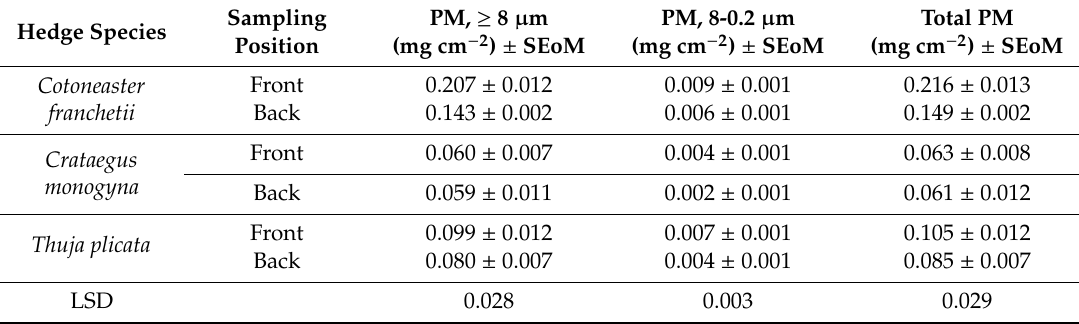
Table 4. Mean mass of particulate matter (in class sizes ≥ 8 µ m, 8-0.2 µ m and total) per leaf area (mg cm − 2 ) of three hedge species ( Cotoneaster franchetii, Crataegus monogyna, Thuja plicata ) at two positions (front and back of hedge), at a distance of 9 metres from the road. Data are mean values